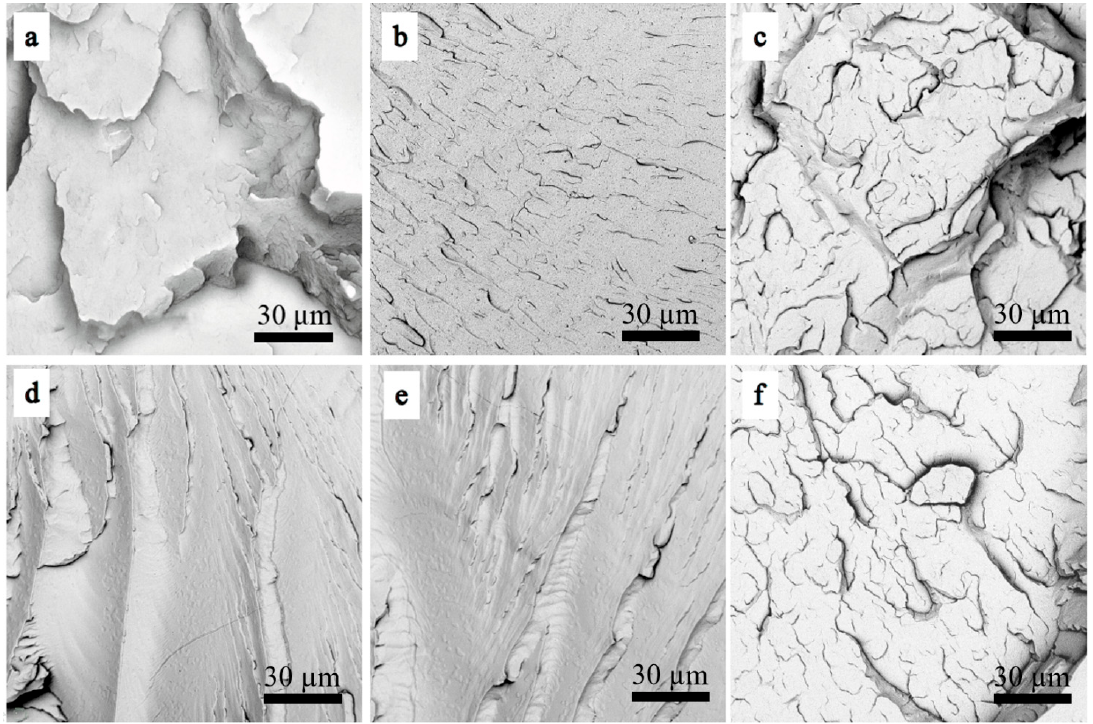
Figure 10. Scanning electron microscopy (SEM) images of the PLA/PPG composites: ( a ) PLA, ( b ) PLA/PPG-200, ( c ) PLA/PPG-400, ( d ) PLA/PPG-600, ( e ) PLA/PPG-800, ( f ) PLA/PPG-1000.